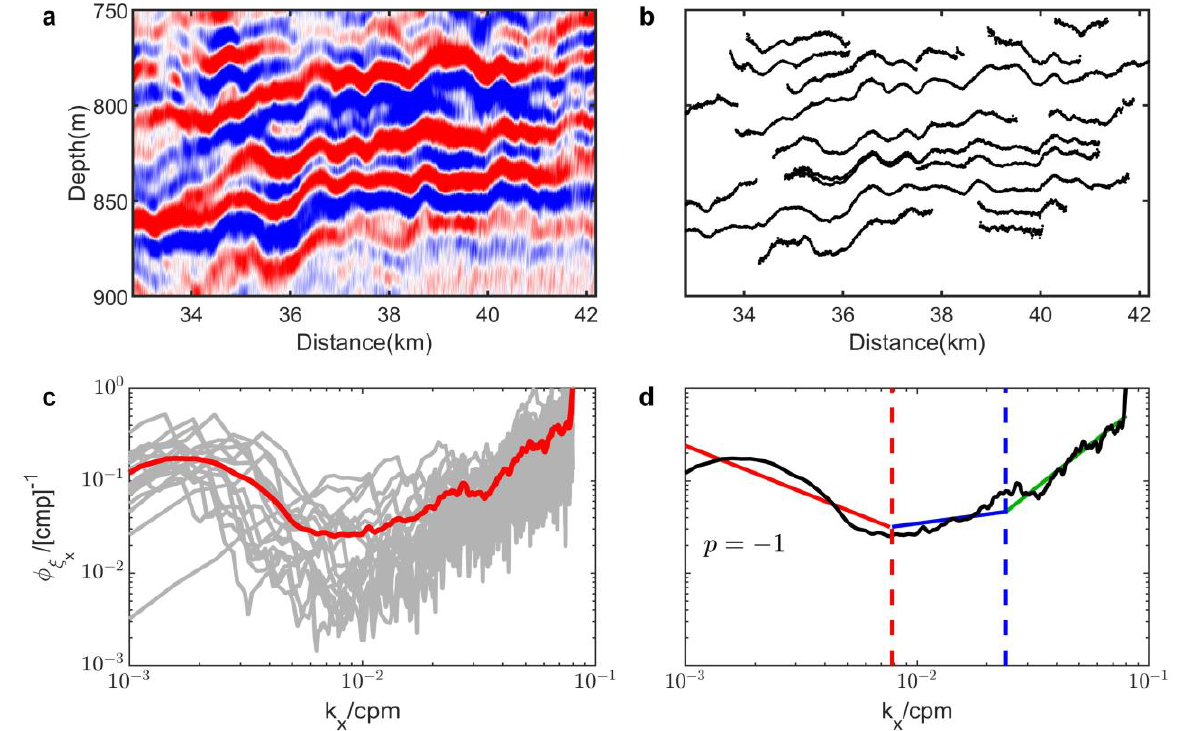
Figure 3. Spectral analysis and theoretical model fitting. ( a ) The zoomed-in seismic section labelled 1 in Figure 2b. ( b ) Corresponding tracked reflectors of ( a ). ( c ) The averaged spectrum. The red line represents the averaged spectrum, and grey lines represent all spectra inside the box. ( d ) The spectrum in ( c ) fitted by the theoretical model. The solid color lines represent the best fit theoretical model. The red line represents the internal wave regime, with a slope of p ranging from − 1 to 0. The blue line represents the turbulence regime with a slope of 1/3, and the green line shows the noise regime with a slope of 2. The red and blue dash lines represent the wavelengths of the internal wave – turbulence break point and turbulence – noise break point, respectively.